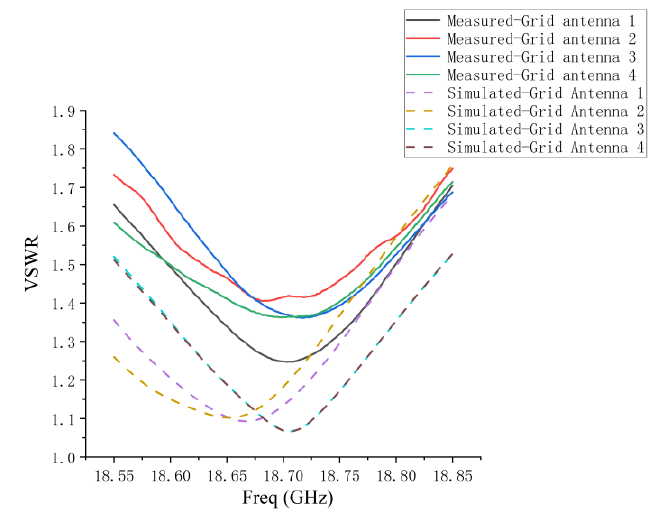
Figure 16. Comparison of measured and simulated VSWR for every antenna element in sparse ar- ray.